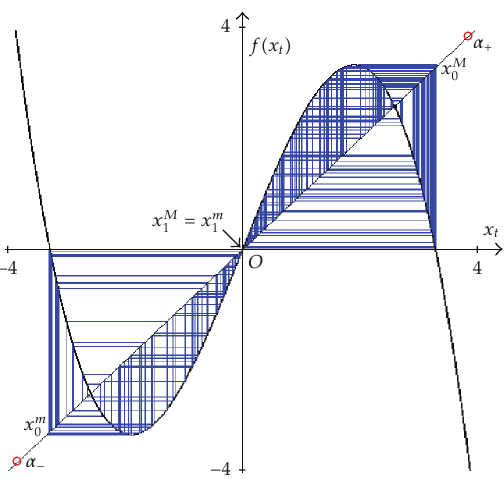
Figure 5: Homoclinic bifurcation of O . The two chaotic intervals around x (cid:7) and around x − merge into a unique chaotic interval for e (cid:4) 4 . 5659 . The remaining parameters are as in Figure 4.